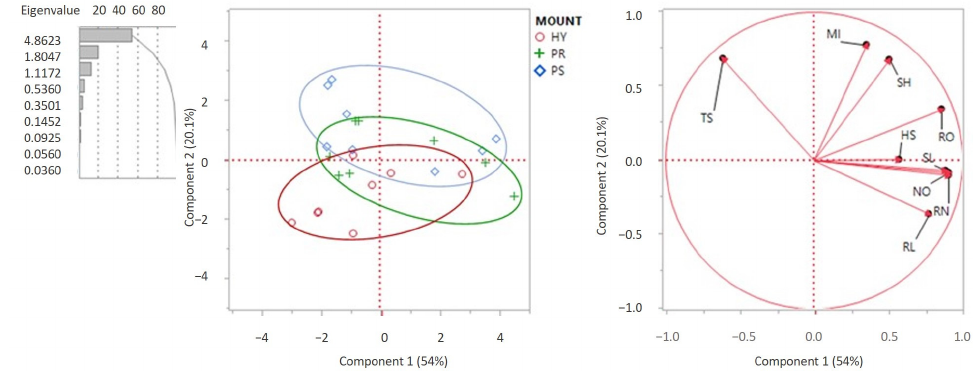
Figure 6. Principal components analysis (PCA) of variables related to in vitro morphogenetic dynamic during establishment, multiplication, and rooting phase of three populations of C. candidissimum